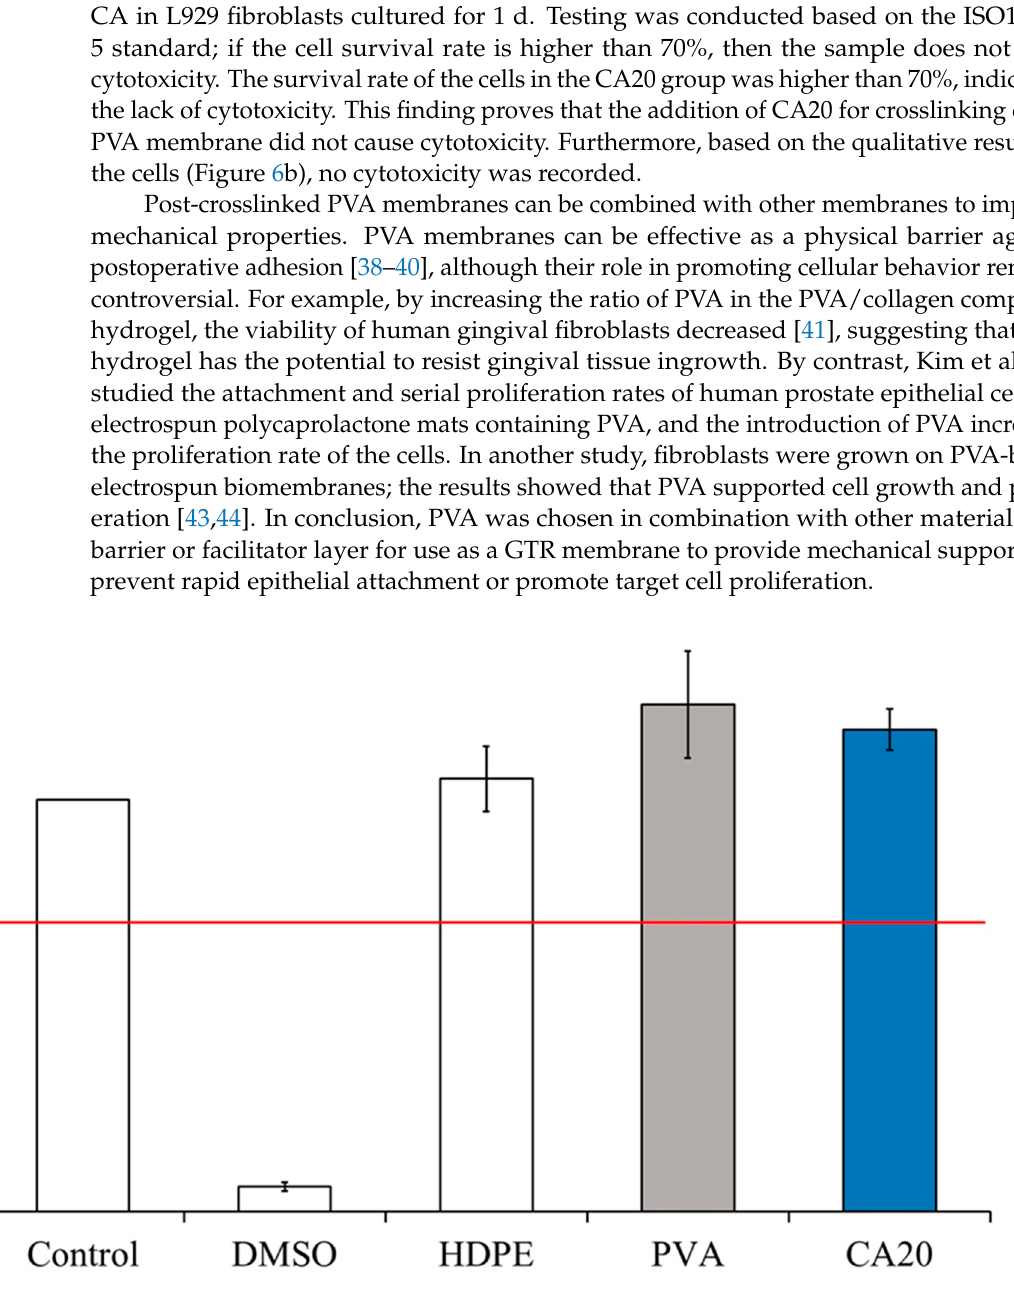
( b ) Figure 6. Cytotoxicity of L929 cells cultured in sample extracts according to ISO 10993-5 speci fi ca- tion: ( a ) quantitative measurements ( n = 3), and ( b ) qualitative cell morphology observation.